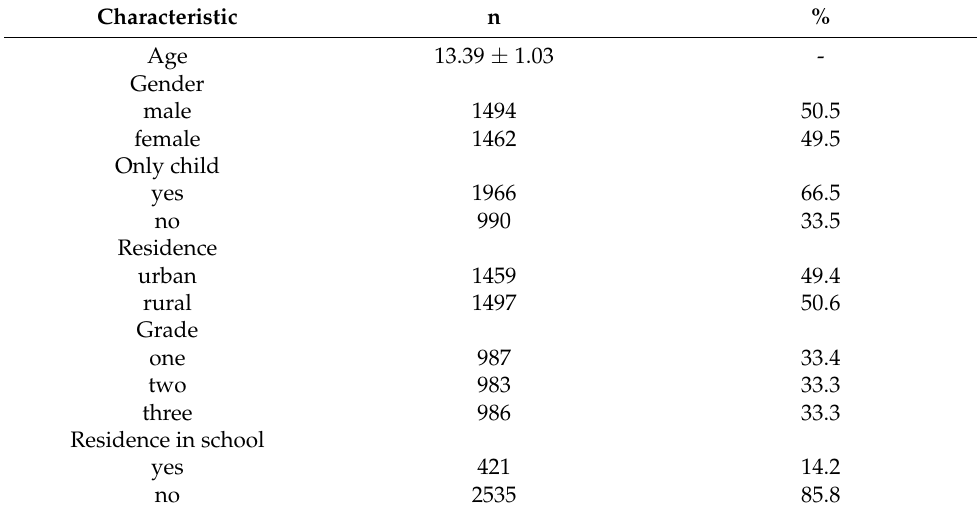
Table 1. Demographics of the study